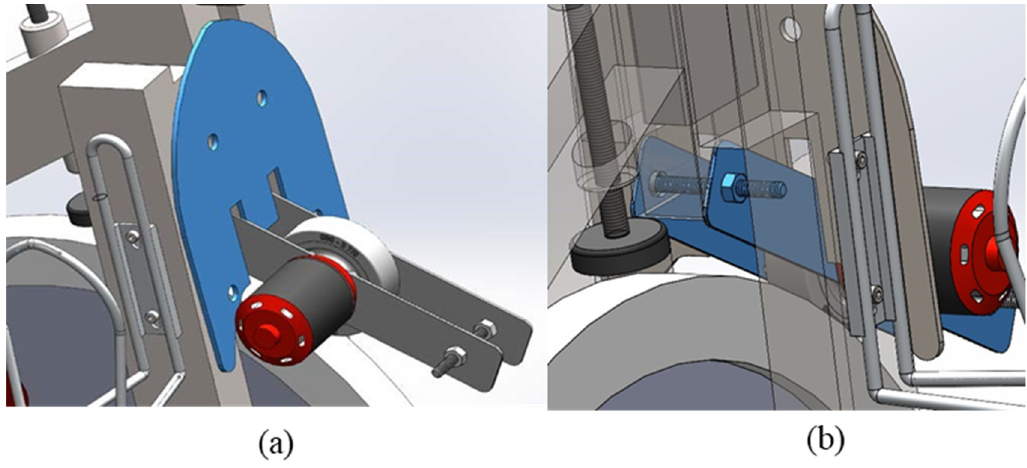
Figure 7. ( a ) The motor mounting and assembly as envisioned; ( b ) the bike frame modification needed to mount the